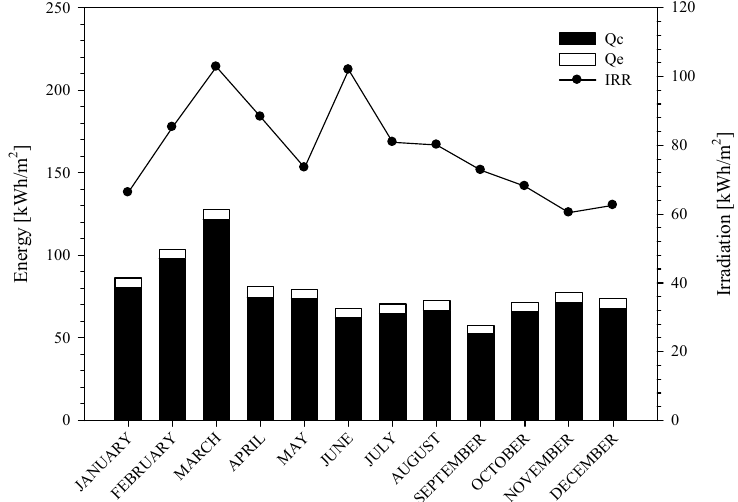
Figure 10. Energy production of a-Si PVT